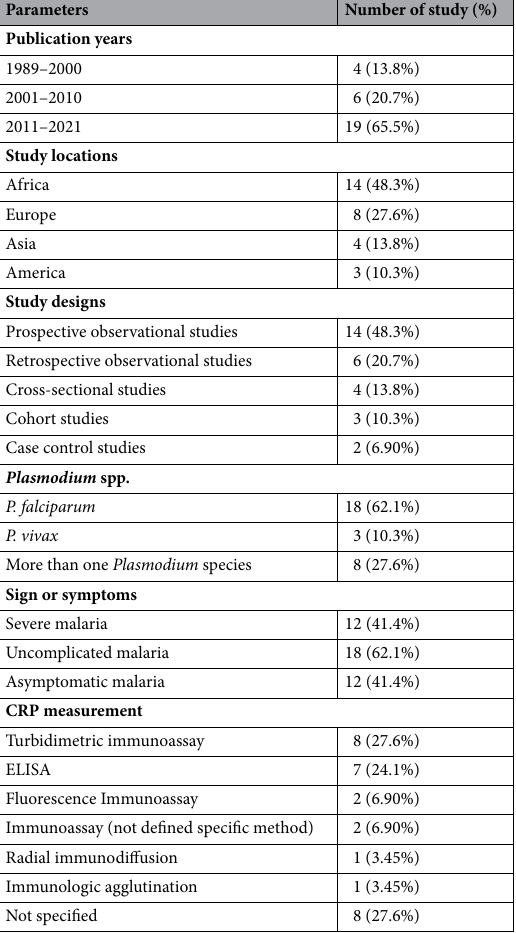
Table 1. Characteristics of the included studies. CRP, C-reactive protein; ELISA, Enzyme-linked immunosorbent